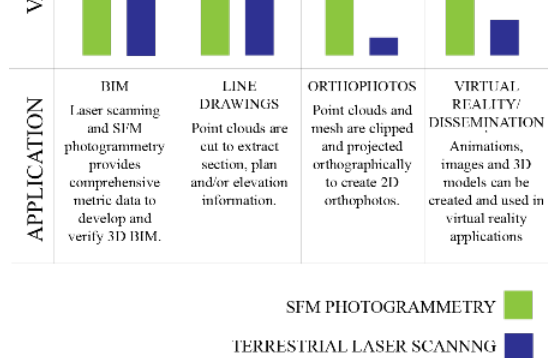
Figure 3: Time and value graph comparing SFM photogrammetry and terrestrial laser scanning (HCS,